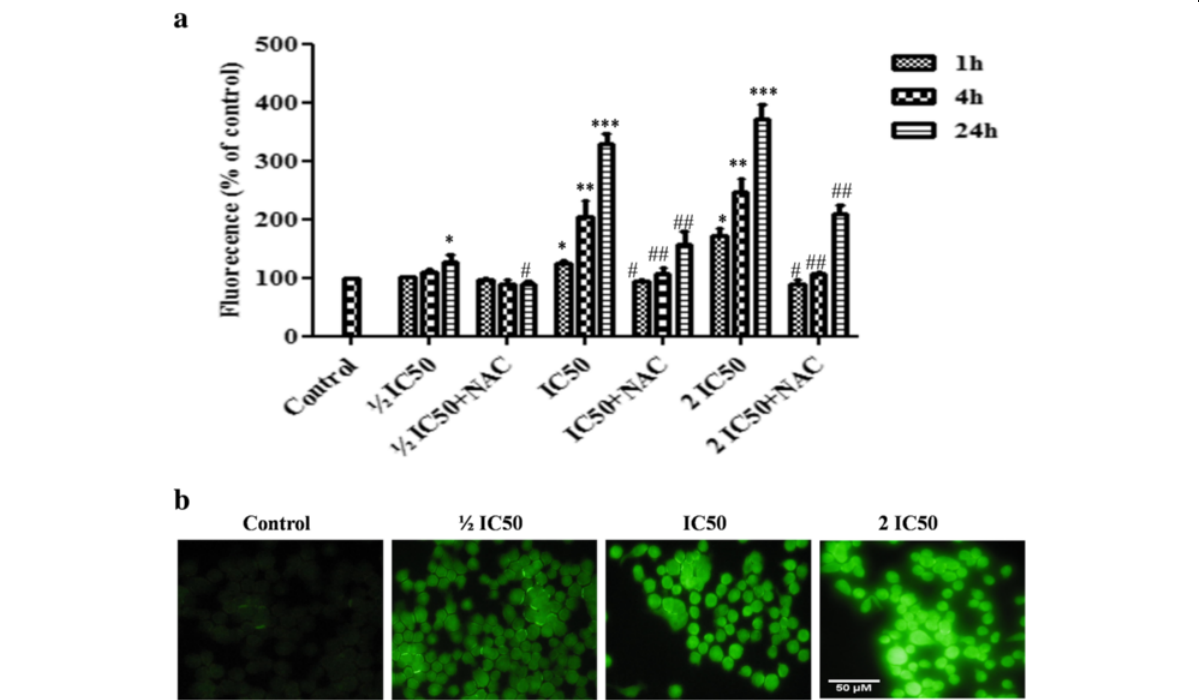
Fig. 6 Intracellular ROS generation in absence ( – NAC) or presence (+NAC) of N-acetylcysteine. a Quantitative intracellular DCF fluorescence intensity of NCI-H358 cells induced by F3 fraction with or without the presence of NAC. The data are expressed as means±SD from three independent experiments. Significances are shown in comparison to control and to the preincubated cells with NAC for each F3 fraction dose (* p <0.05; ** p <0.01; *** p <0.001; vs. control and # p <0.05; ## p <0.01, vs. the corresponding dose of F3 fraction with NAC pre-treatment). b Microscopic images of ROS generation in